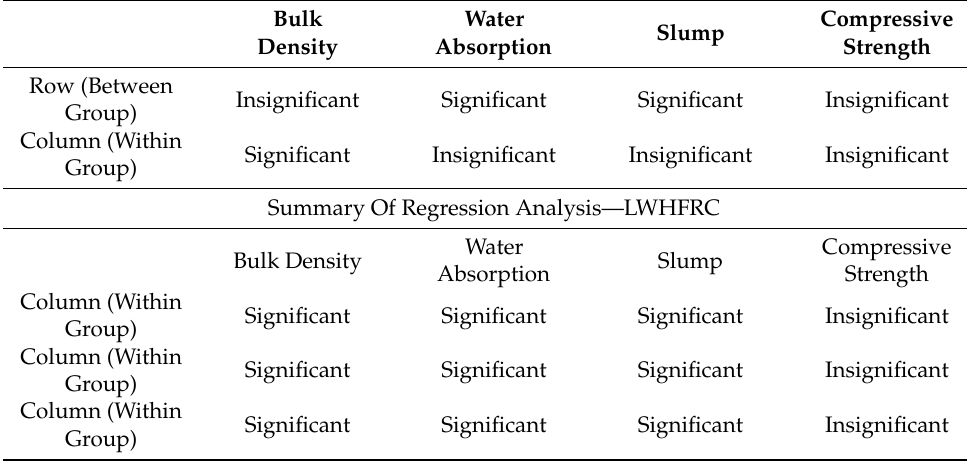
Table 11. Summary of ANOVA analysis—LWHFRC.